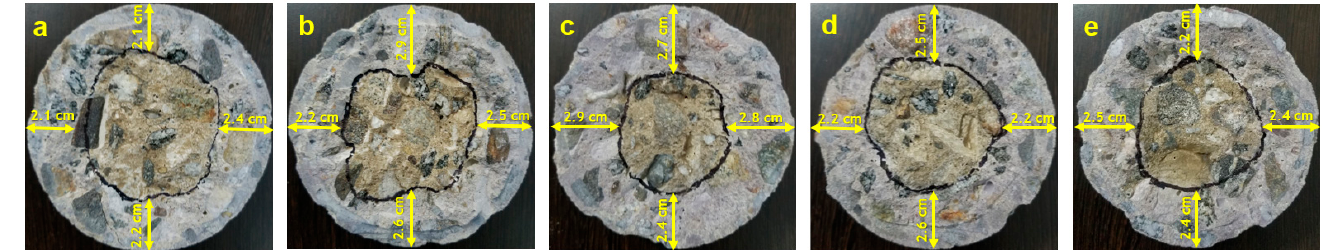
Figure 6. Chloride ion penetration in concrete at 91 days of exposure: ( a ) Blank, ( b ) Neem, ( c ) Sika CNI, ( d ) Eucon CIA and ( e ) DCI.